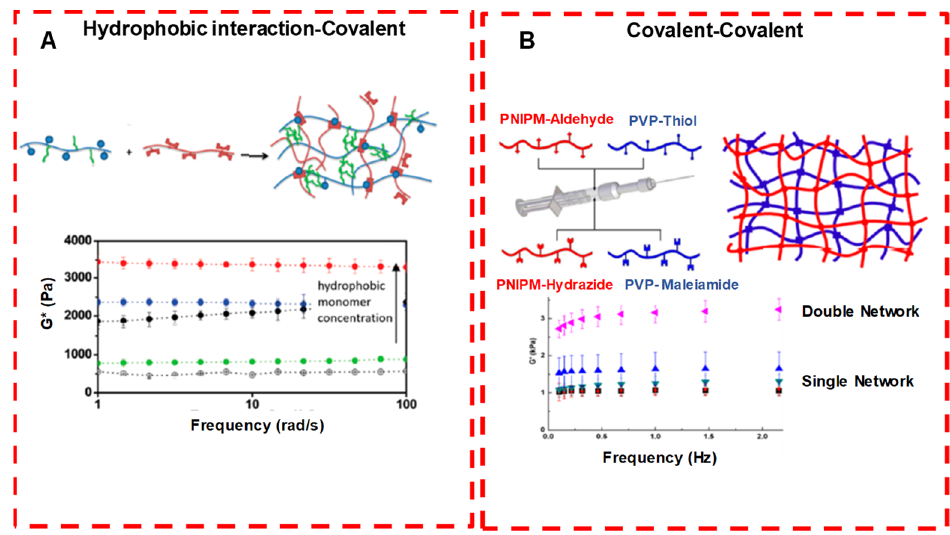
Figure 12. Crosslinking strategies for forming injectable double network hydrogels. ( A ) Hydrophobically associated and covalently crosslinked POEGMA hydrogels: by increasing the concentration of the hydrophobic co-monomer, gel modulus is increased. ( B ) Dual covalently crosslinked hydrogels composed of aldehyde/hydrazide functionalized PNIPAM and thiol/maleimide functionalized PVP: the presence of both kinetically orthogonal crosslinking groups results in enhanced mechanics compared with either single network alone. Adapted with permission from ref. [34]. Copyright © 2020 ACS Applied Polymer material .